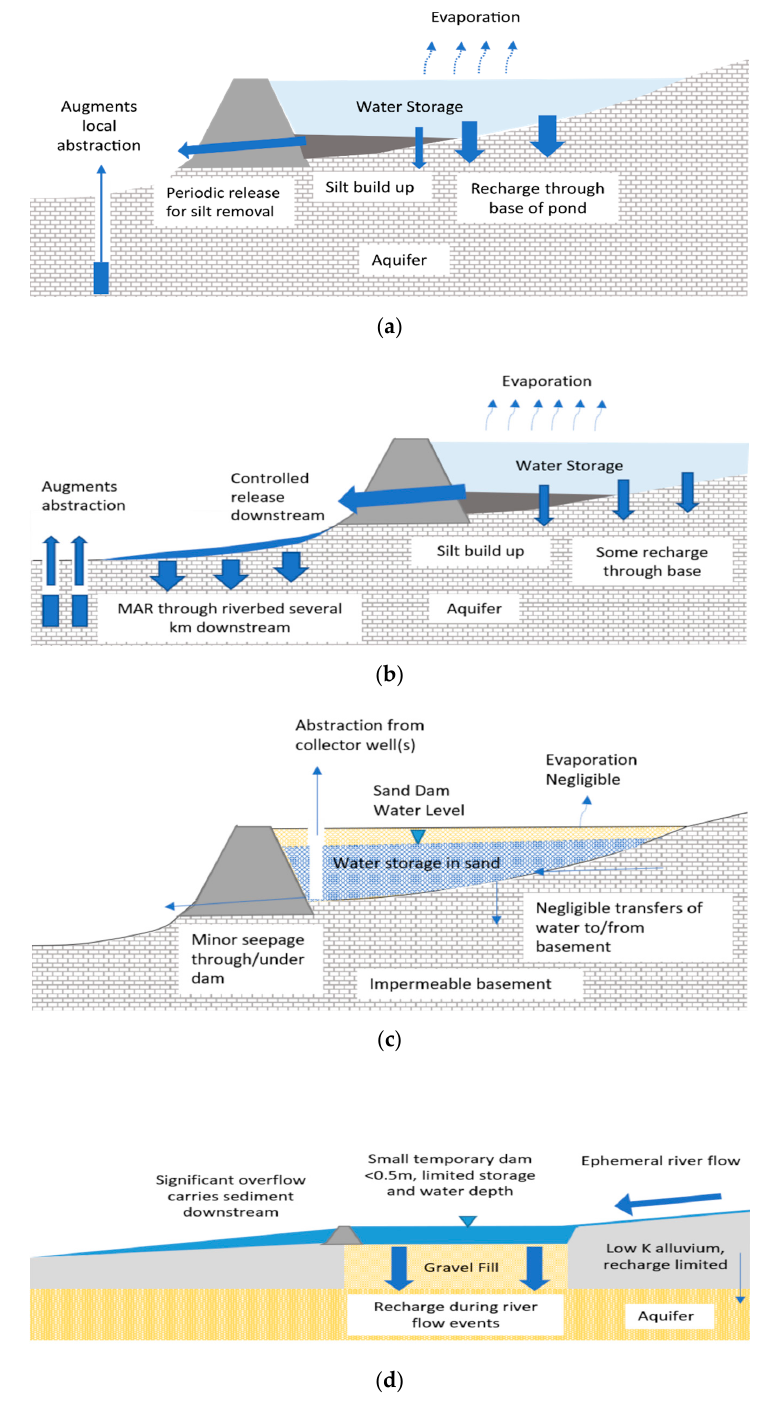
Figure 1. Types of in-channel modification for managed aquifer recharge (MAR): ( a ) a recharge dam where the majority of recharge occurs through the base of the pond, ( b ) a wadi-recharge dam where recharge is increased by controlled release downstream and infiltration through the riverbed, ( c ) a sand storage dam where water is stored within the semiartificial aquifer built up behind the dam, and ( d ) a riverbed modification to enhance recharge by removal of alluvial sediments and replacement with gravel fill.